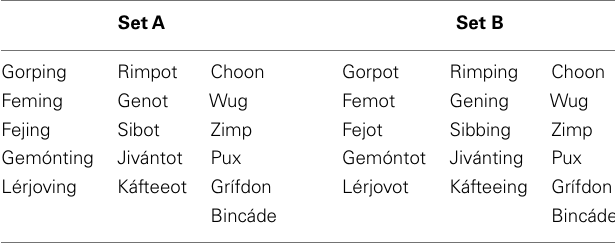
Table 1 | Familiarization material for experiment